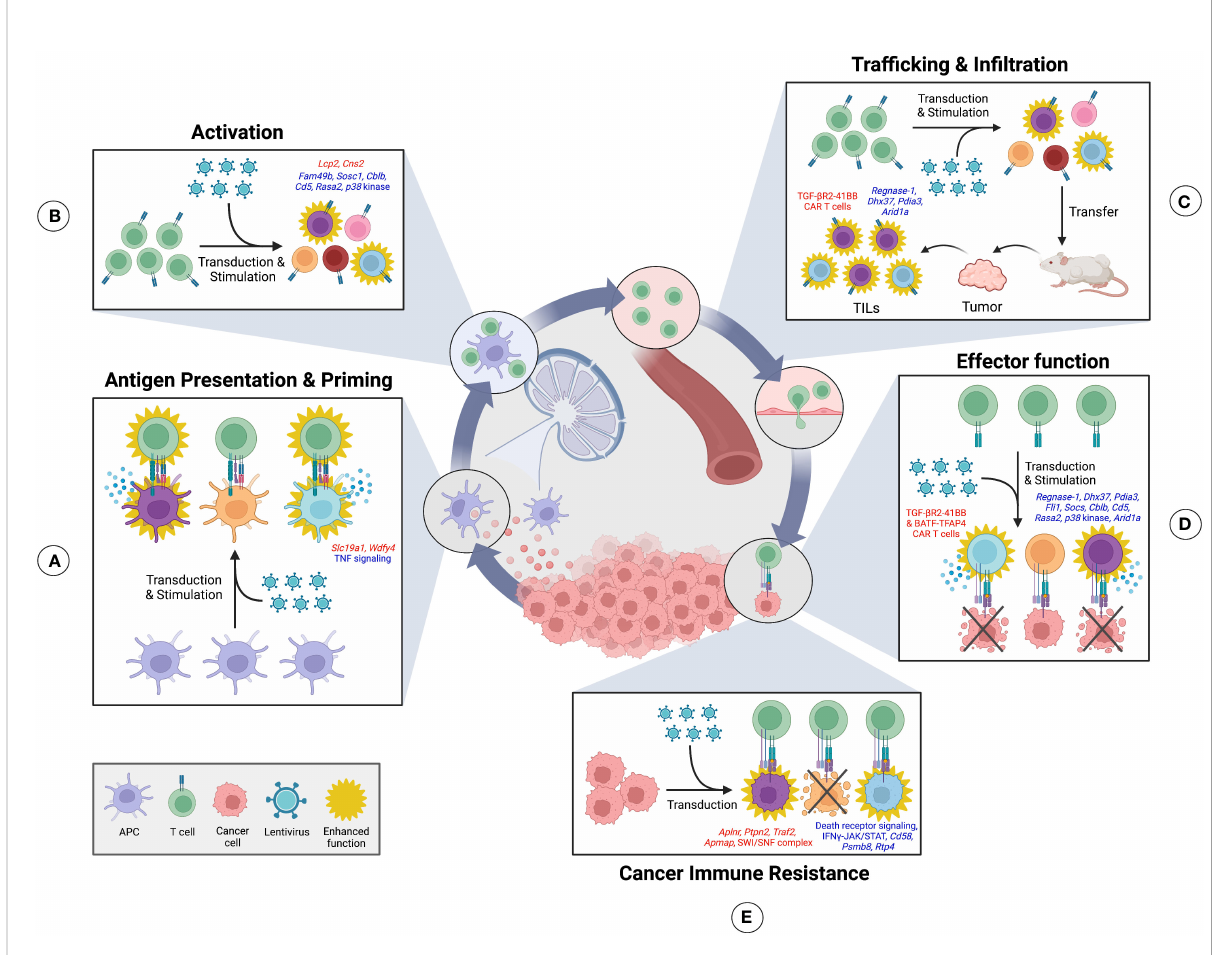
FIGURE 1 CRISPR screens can identify regulators of the Cancer-immunity cycle. The cancer-immunity cycle is a framework which describes the sequential generation of antitumor immune responses. High-throughput CRISPR screening can be used to screen cells in each step of this cycle to discover regulatory genes and their corresponding phenotypic effect. (A) In this cycle, tumor antigens are fi rst released by cancer cells and sampled by antigen-presenting cells (APCs), such as dendritic cells, that may release cytokines in response to stimulation. APCs can then process and present captured antigens using major histocompatibility complex proteins on their surface. Traf fi cking of APCs to nearby lymph nodes allows for presentation of cancer antigens to naïve T cells for subsequent T cell activation. Screens on APCs can uncover genes regulating APC stimulation in response to tumor antigens and antigen presentation ef fi ciency to T cells. (B) T cells that receive antigen stimulation become primed and activated towards a given tumor antigen. T cell screens can identify genes that mediate activation ef fi ciency. (C) Primed T cells, such as cytotoxic T lymphocytes, can then egress from the lymph node, migrate through the blood, and in fi ltrate the tumor as tumor in fi ltrating lymphocytes (TILs). In vivo T cell screens can discover genes that promote TIL traf fi cking and in fi ltration. (D) Within the tumor, T cells are fi nally able to recognize their cognate cancer-speci fi c antigen and induce tumor cell killing. T cell screens can identify genes that enhance tumor-killing activity. (E) Meanwhile, screening of tumor cells can uncover genes that mediate resistance to T cell killing. Positive regulators discovered at each step using CRISPR screens are shown in red, while negative regulators are shown in